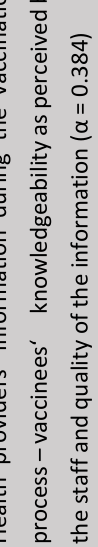
Figure 5. Perception of the vaccination centre staff of the information provision prior to inoculation.